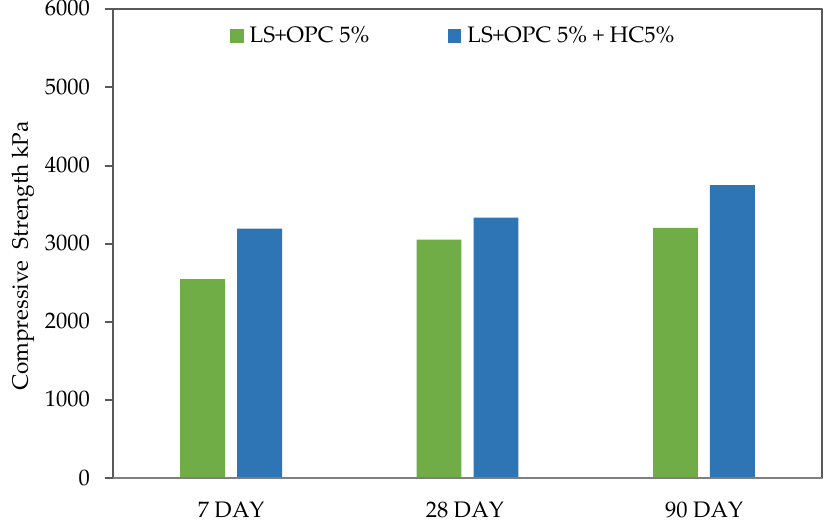
Figure 4. Compressive strength for curing ages of 7, 28, and 90 days under water.